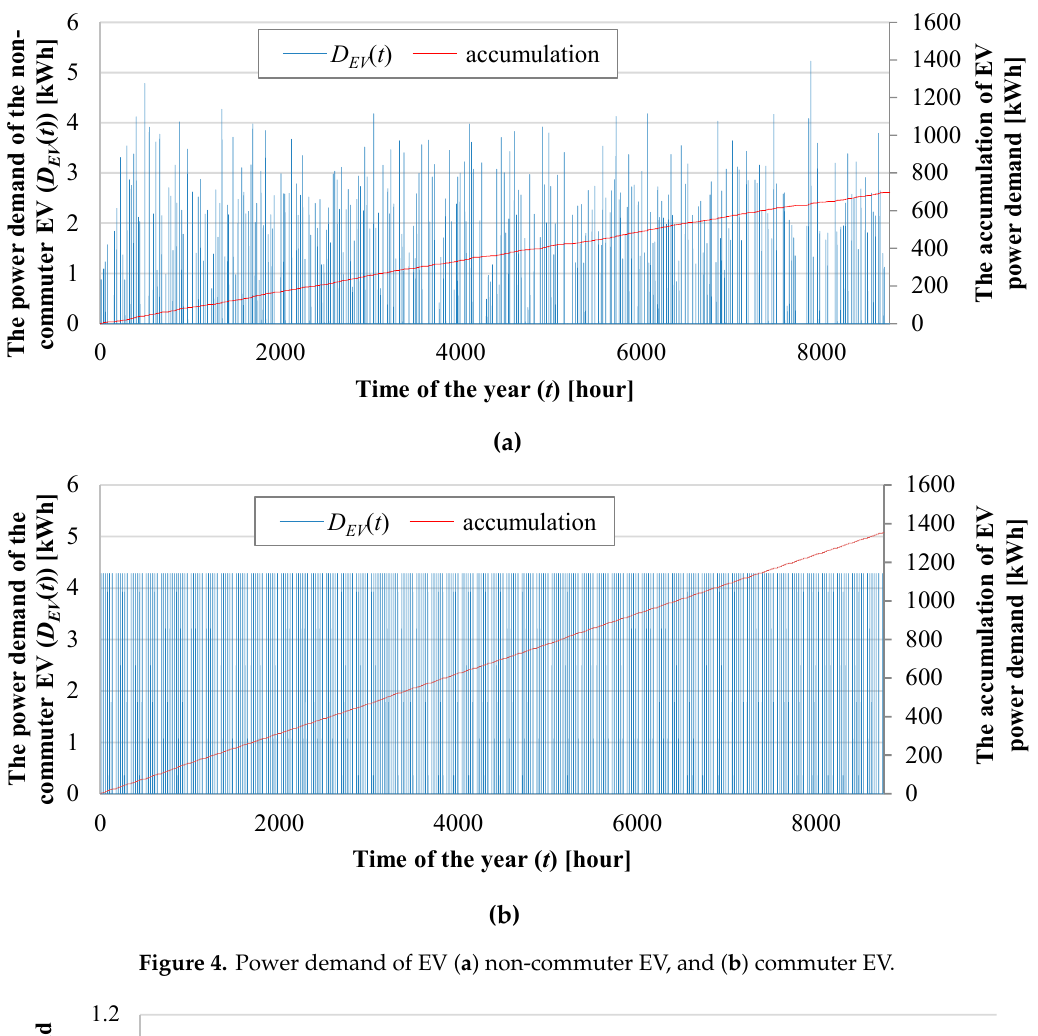
Figure 4. Power demand of EV ( a ) non-commuter EV, and ( b ) commuter EV.